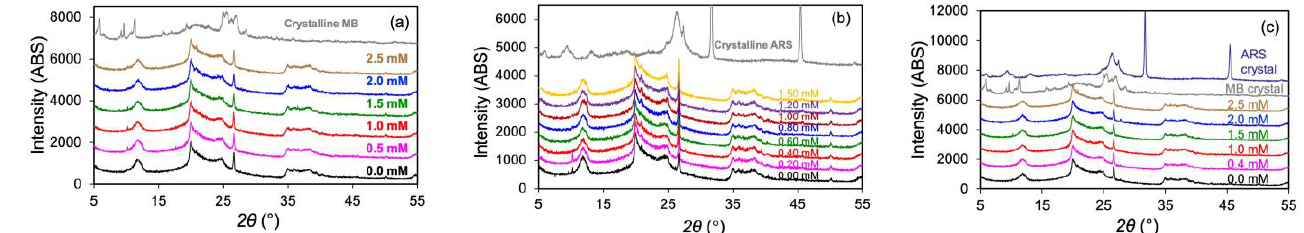
Figure 5. XRD patterns of the HNC after MB ( a ) and ARS ( b ) sorption from a single solution of different initial concentrations and a mixed solution of different initial concentrations ( c ). Both dyes have the same initial concentration, as indicated by the concentration values above each line.